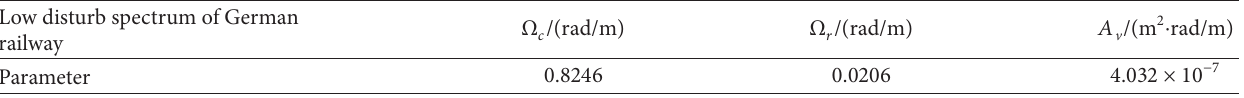
Table 3: Characteristic parameter of the power spectral density of German railway low disturb spectrum.